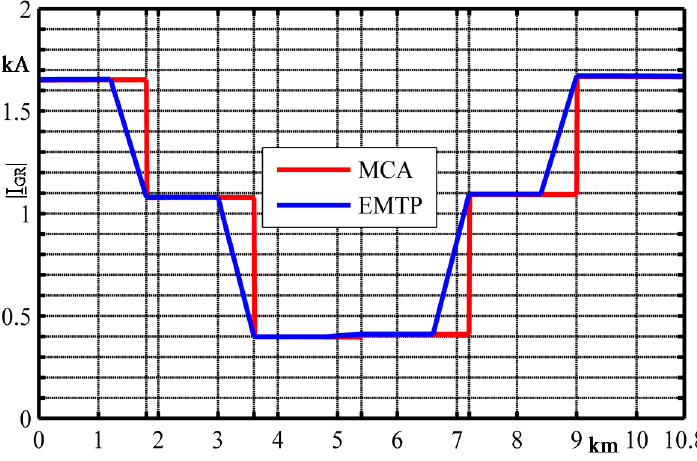
Figure 16. | I GR | under phase-to-screen short circuit in a single circuit